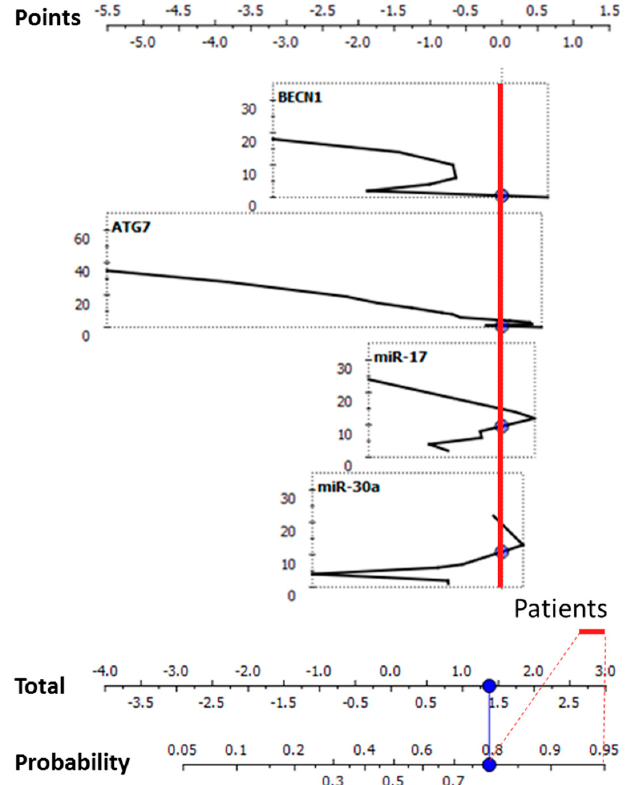
Figure 5. Nomogram tool to predict CD status in the intestinal biopsy specimens. The nomogram (lower graph) was created considering the relative quantitative expression values of the analyzed genes/miRNAs (upper graphs). The red line evidences the portion of the curves (on the right side of each) that confers a high probability ( p > 0.8) to correctly classify a CD condition.